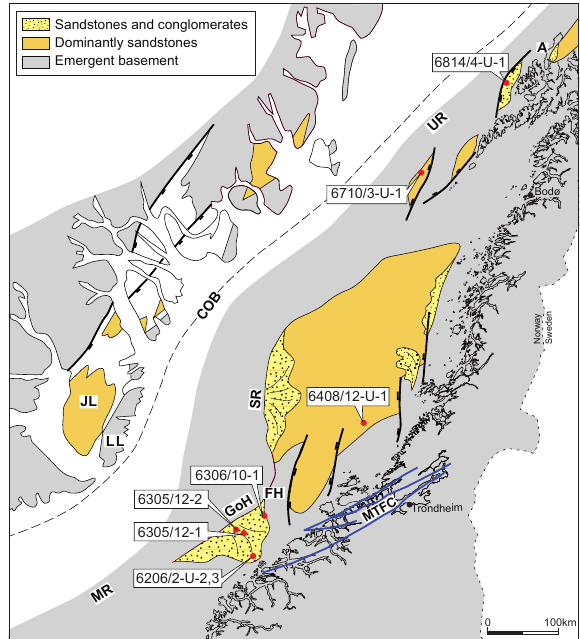
Figure 11. Early Jurassic–early Middle Jurassic paleogeography. Coarse-clastic sediments dominate in the eastern part of the Norwegian Sea. On the western Halten Terrace and beneath the southeast Møre Basin, sandstones and conglomerates were derived from exposed basement to the